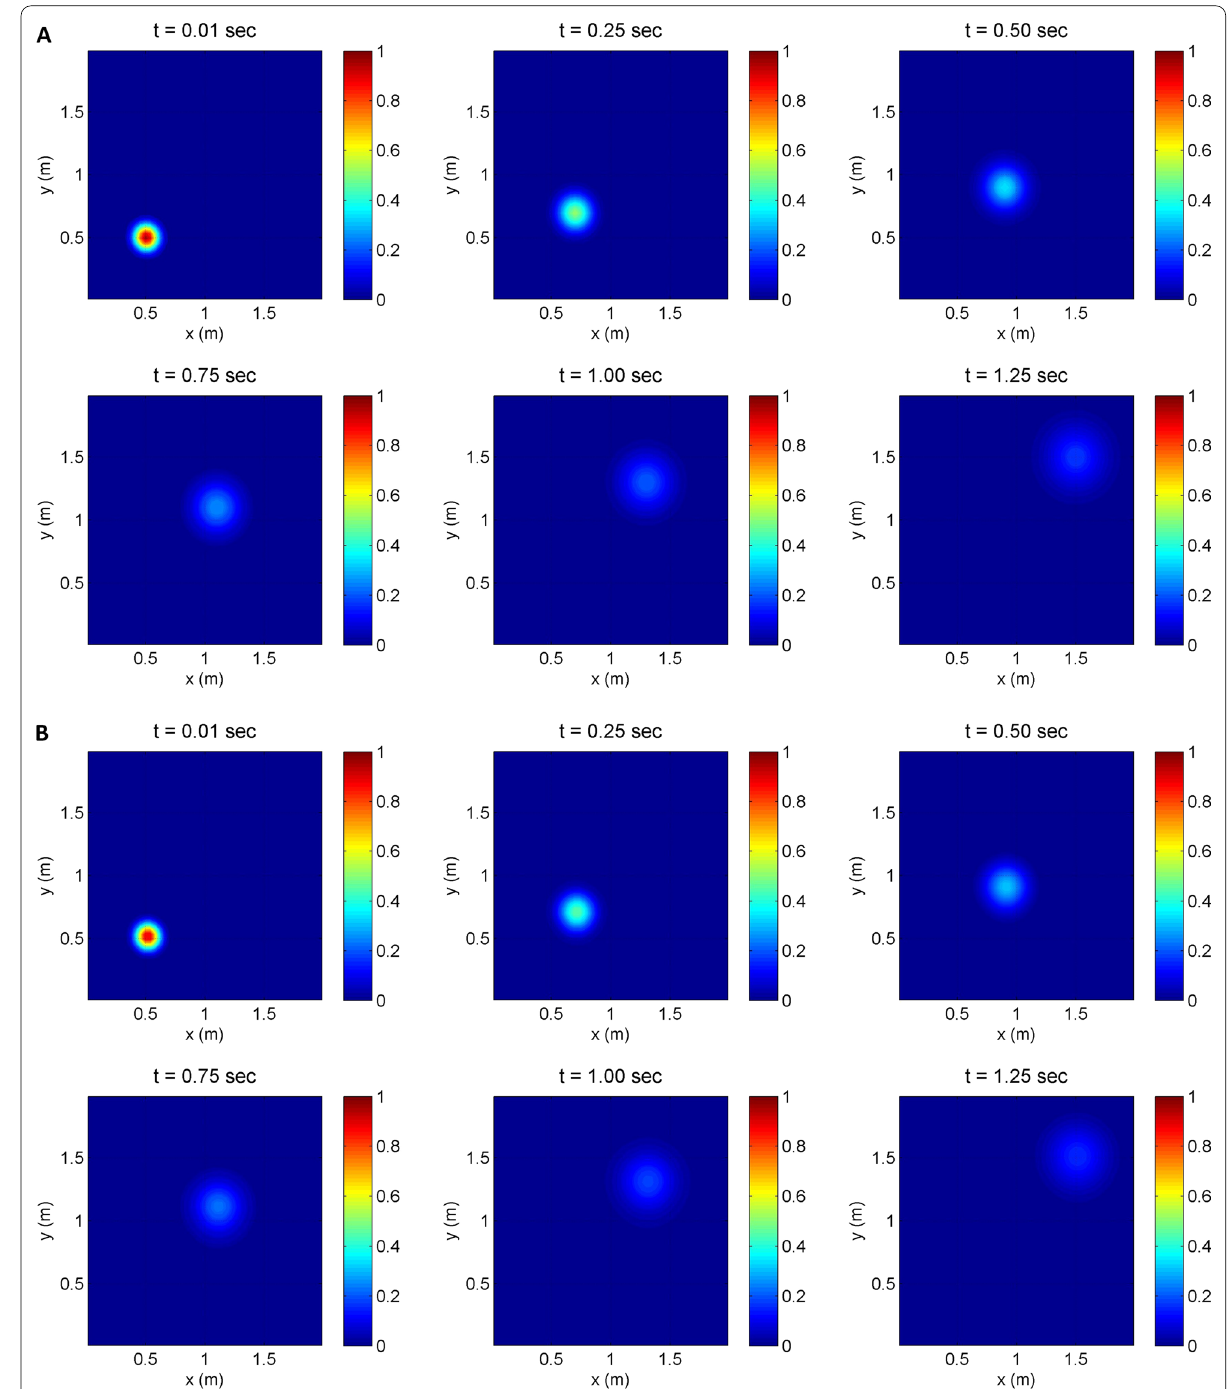
Fig. 3 Analytical ( A ) and numerical ( B ) results for the test case 3.1.2, for three timesteps ( t